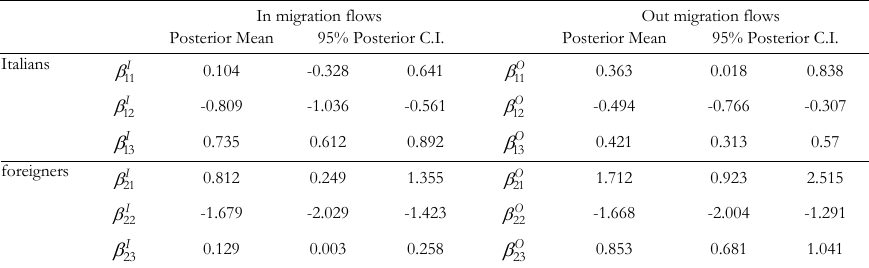
Estimated regression coefficients and 95% credibility